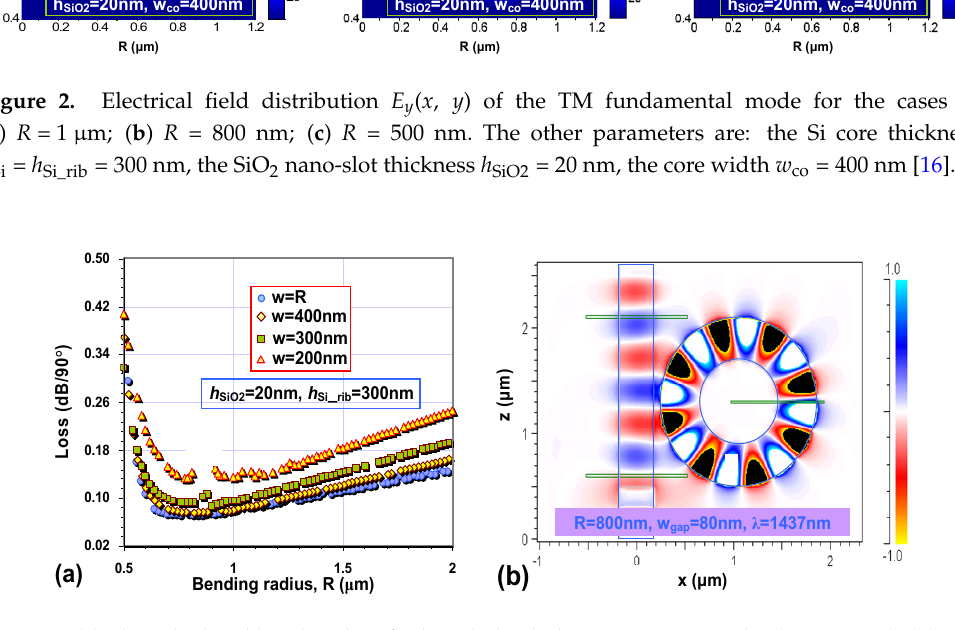
Figure 3. ( a ) The calculated bending loss for bent hybrid plasmonic waveguides (at 1550 nm); ( b ) The electrical field distribution E y ( x , z ) in a submicron-donut resonator with R = 800 nm, and w g = 80 nm when it is on-resonance. The other parameters are: the Si core thickness h Si = h Si_rib = 300 nm, the SiO 2 nano-slot thickness h SiO2 = 20 nm [16].